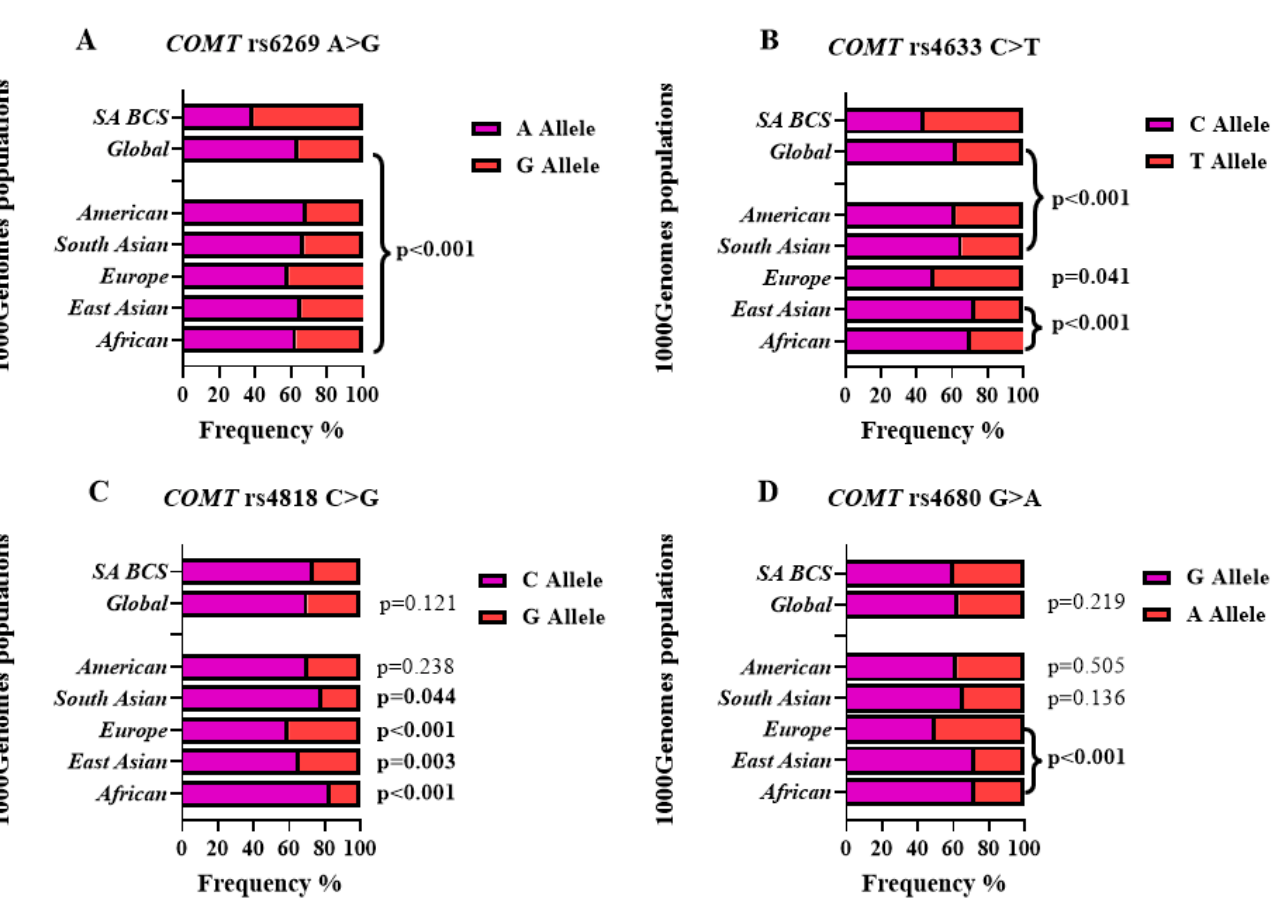
Figure 1. The global distribution and prevalence of allele frequencies for the COMT SNPs (rs6269 A > G, rs4633 C > T, rs4818 C > G, and rs4680 G > A) were obtained from the public database, NCBI- 1000Genomes project (Accessed: 23 August 2021 [ https://www.ncbi.nlm.nih.gov/snp/] ). Displayed are the minor allele frequencies for ( A ) rs6269 A > G, ( B ) rs4633 C > T, ( C ) rs4818 C > G, and ( D ) rs4680 G > A are shown for the SA BCS cohort in comparison to the global populations. P values describe the comparison in frequency distribution between the SA BCS cohort, and the global and super populations. Significant p values (p < 0.05) are in bold type set .